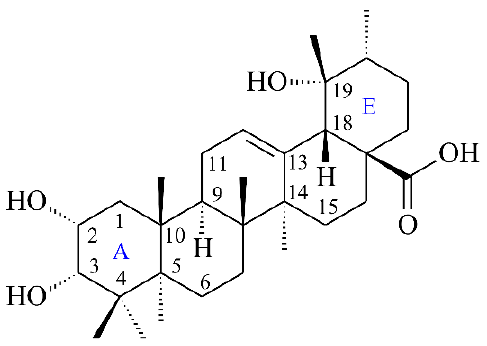
Figure 4. The chemical structure of euscaphic acid ( 5 ).